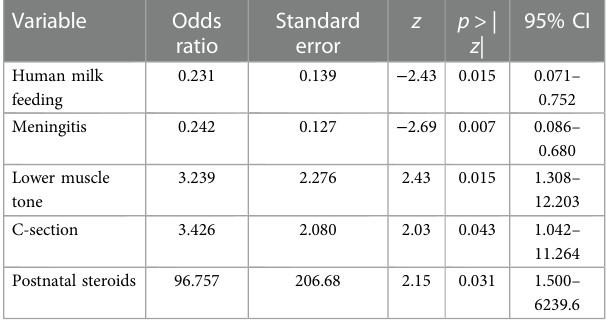
TABLE 3 Multivariate logistic regression analysis of factors associated with higher vasopressor support.